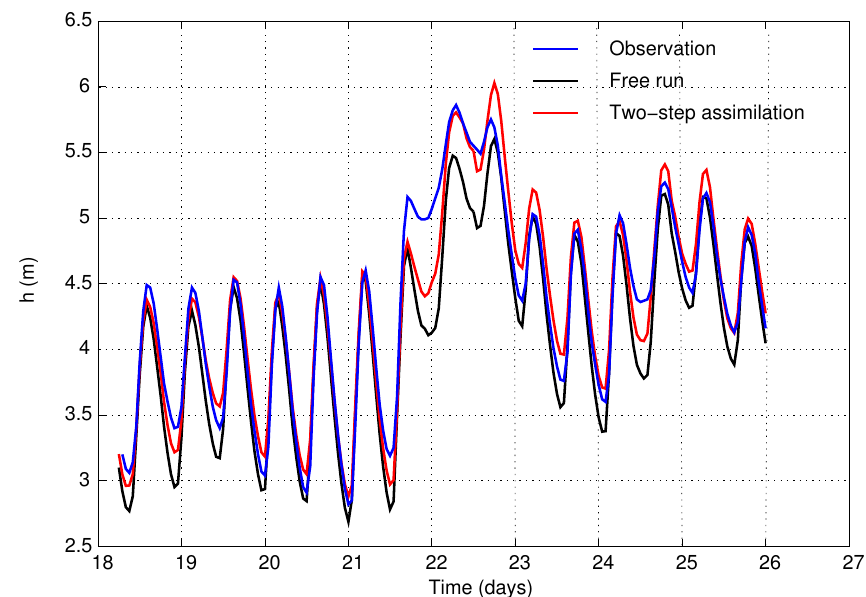
Fig. 9. November 2002 event, Adour catchment. Six-hour forecasted water level at Peyrehorade for the Free run (black curve), the observa- tion (blue curve) and the analysis of the Assim run with the two-step assimilation (red curve).